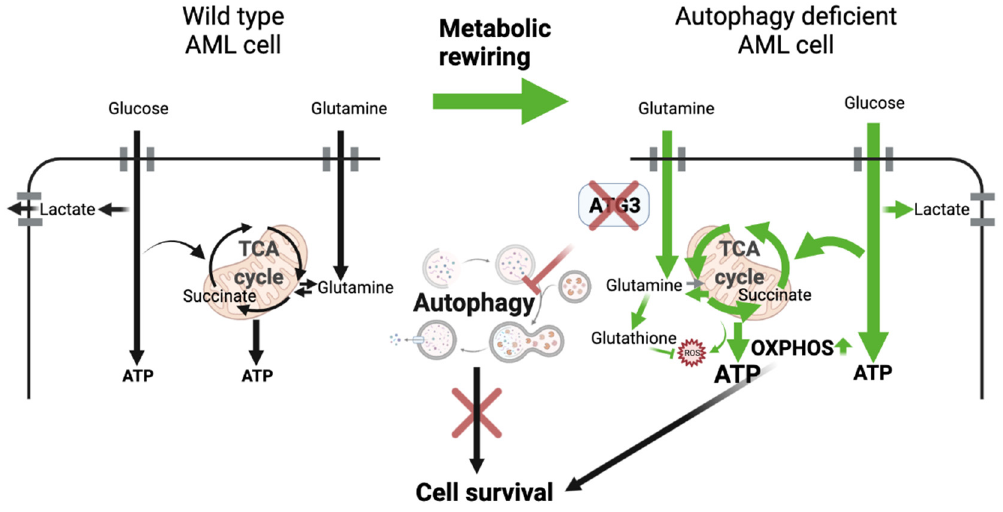
Figure 6. Model of metabolic rewiring in AML cells upon loss of ATG3. Loss of ATG3 upregulates the intracellular glucose uptake and glycolysis thereby increasing lactate production. Lactate export, however, is not increased in ATG3-deficient cells, resulting in an accumulation of lactate within the cells. ATG3 deficiency further results in an upregulation of OXPHOS with elevated ATP levels accompanied by enhanced mitochondrial ROS generation. This metabolic rewiring promotes cell survival in ATG3-deficient cells and increases their dependence on OXPHOS. The model was created with BioRender.com, accessed on 25 November